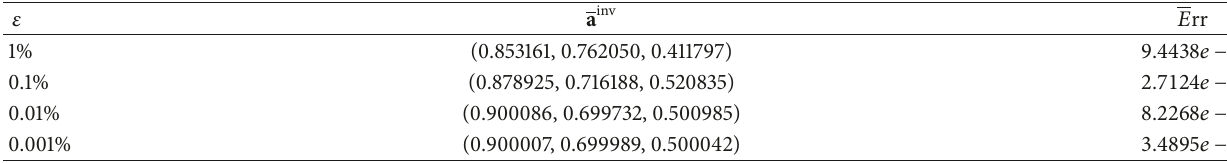
Table 5: The inversion results using noisy data for 𝑆 = 2